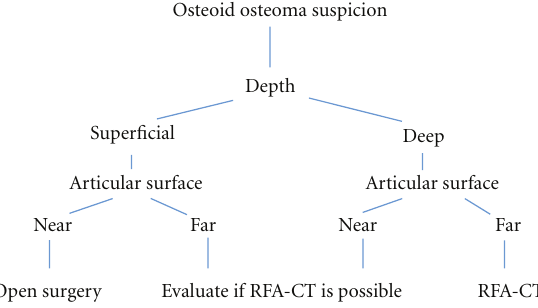
Figure 4: Algorithm propose of